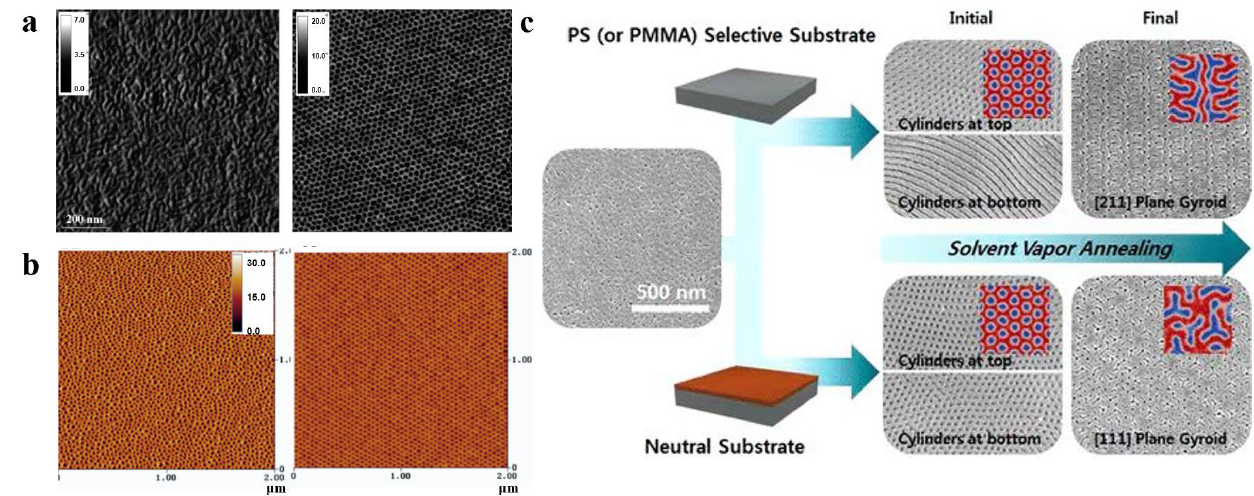
Figure 4. ( a ) AFM phase images (1 × 1 μm 2 ) of as-cast conventional PS-b-PEO film and PS-b-PEO film annealed in PS-selective toluene vapor for 5 min [66]. ( b ) AFM phase diagrams of PS-b-PEO films obtained by spin-coating method and annealed in neutral benzene vapor for 48 h [73]. ( c ) SEM images of the (111) and (211) planes produced by solvent vapor annealing of PS-b-PMMA films in neutral substrate and selective substrate [76].